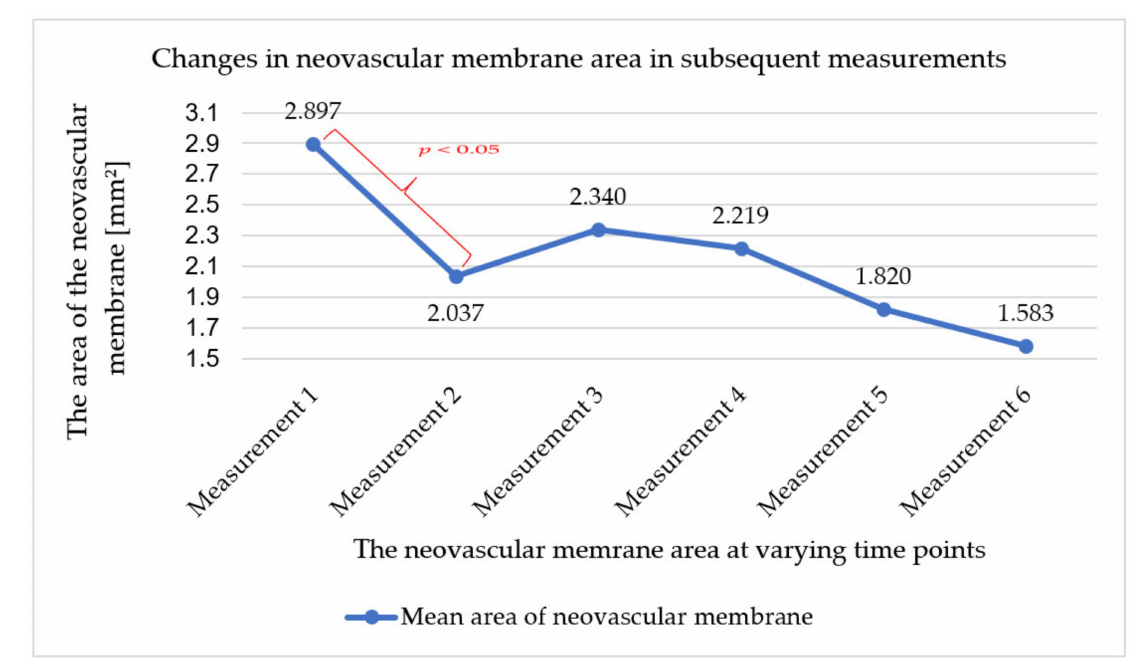
Figure 3. Changes in mean neovascular membrane area in subsequent measurements. Color indicates statistically significant differences between two consecutive measurements.